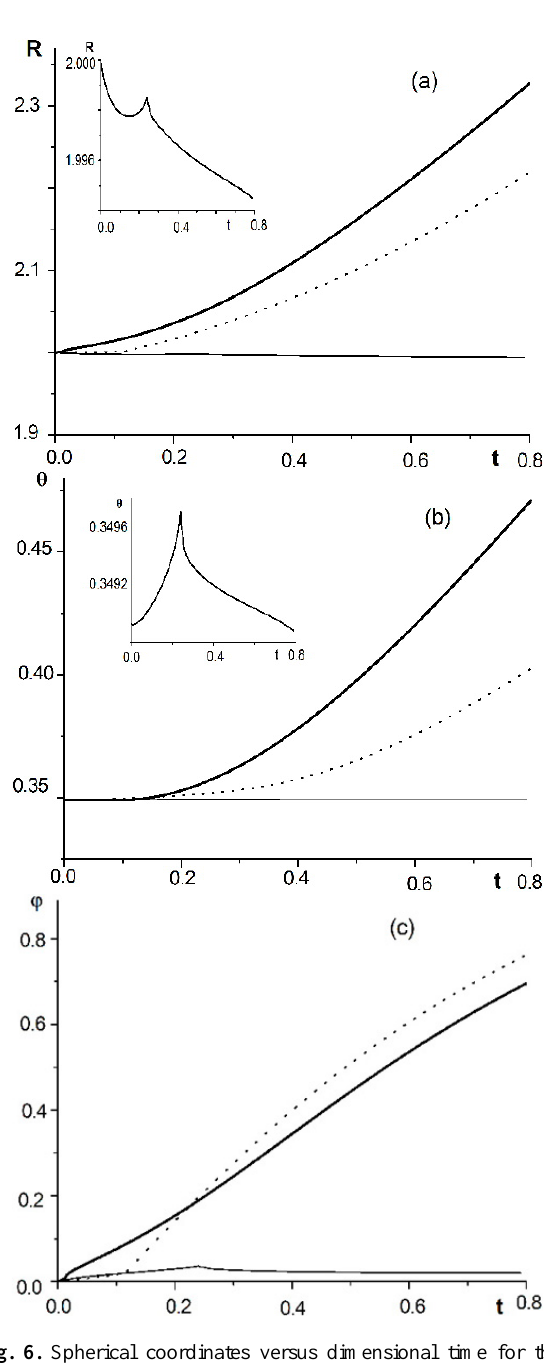
Fig. 6. Spherical coordinates versus dimensional time for three wave packets with initial wave vector components k θ = 0 , k ϕ = 0 . 95 and different values of k r . Thick solid lines correspond to k r = 0 . 2, dotted lines to k r = 0, and light solid lines to k r = − 0 . 2. The behavior of the wave packet initially propagating to the Earth ( k r = − 0 . 2 ) is additionally shown on the enlarged scale in the in-